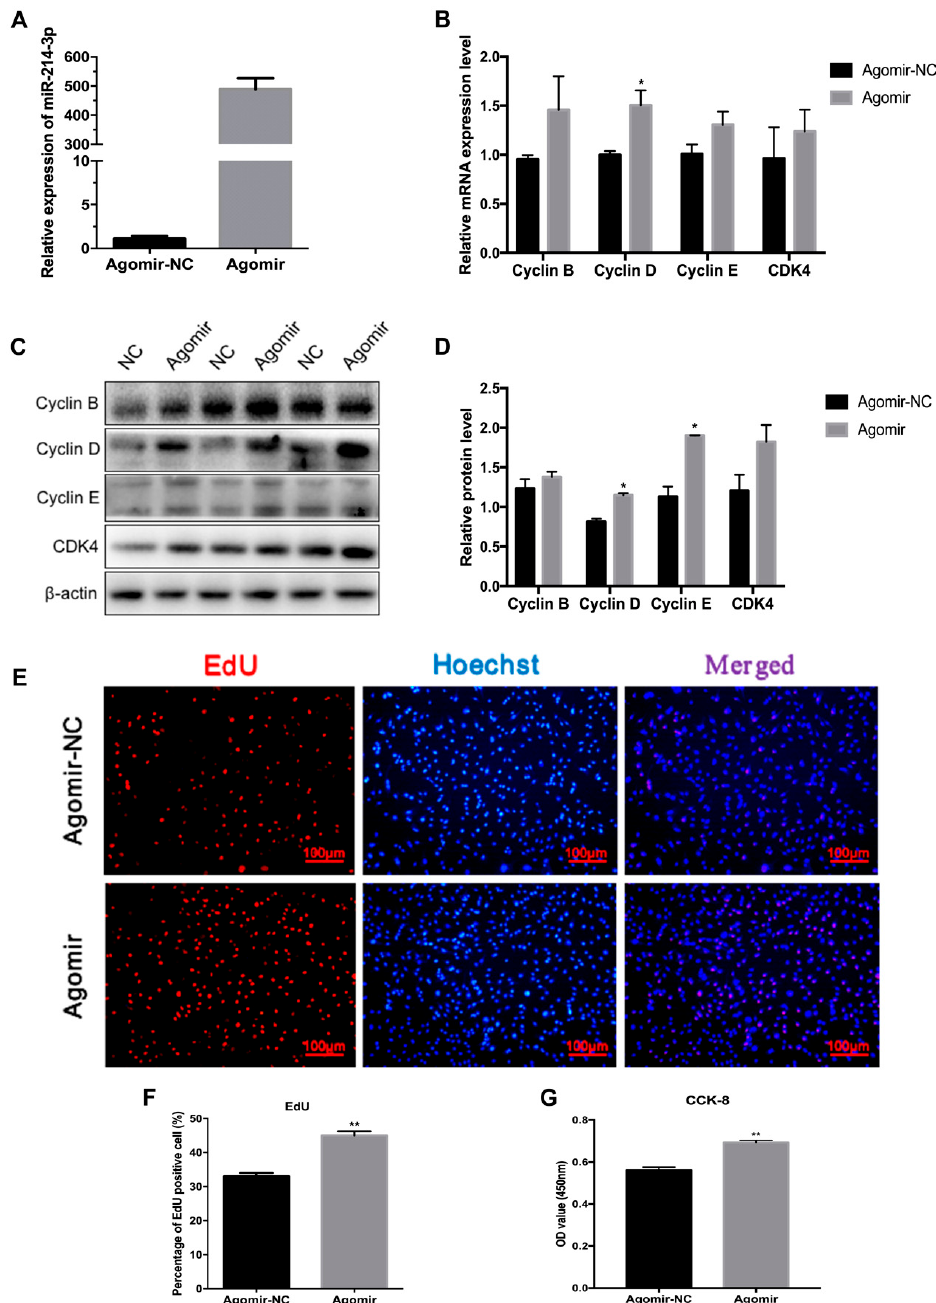
Figure 3. MiR-214-3p promotes the cell cycle process and upregulates the expression of cell cycle genes. MiR-214-3p agomir or negative control (NC) were transfected into cells at 50% density at 50 nM, and cells were harvested 24 h after transfection. ( A ) The overexpression e ffi ciency of miR-214-3p after transfection with the miR-214-3p agomir compared with the negative control (NC); ( B ) Real-time qPCR was used to detect cell cycle genes, Cyclin B, Cyclin E, Cyclin D, and CDK4 after 24 h of transfection; ( C ) Western blot analysis of cell cycle genes; ( D ) Quantification of Western blot analysis of Cyclin B, Cyclin D, Cyclin E, and CDK4; ( E ) EdU staining assay was carried out after transfection for 24 h. Cells during DNA replication were stained by EdU (red), and cell nuclei were stained with Hoechst (blue), (bar size = 100 µ m); (F) The percentage of EdU positive cells / Hoechst positive cells was quantified. (G) CCK-8 assay was used to detect cell viability after transfection for 24 h—results represent the absorbance value at 450 nm after incubation with 10% CCK-8 solution for 4 h. Statistical results were representative of mean ± SEM, n = 3. * p < 0.05; ** p < 0.01, vs.